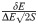
Binding specificity of ssDNA vs. ssRNA.To judge the specificity with which different sequences of ssDNA and ssRNA bind to the cold shock protein (2ES2.pdb and 3PF5.pdb, respectively), the intrinsic specificity ratio, ISR = δEΔE√2S, was calculated. The δE term represents the energy gap between the native binding state (average binding energy of all near-native structures from the simulation obtained by applying the condition DConf1,DConf2≤3Å) and the average non-native binding states (average binding energy of all non-native binding conformations from the simulation), ΔE is the energy variance of the non-native states and S is the entropy of binding energy. The non-native interactions are defined as conformations that have low binding energy (i.e., a negative binding energy) and that satisfy DConf1,DConf2>3Å). The entropy is estimated as Σplog(p), where p is the probability of having non-native conformation with a certain binding energy obtained by binning. Panels show the values of δE, ΔE, S, and specificity for complexes of the cold shock proteins with ssDNA (red) and ssRNA (blue). A higher energy gap, lower energy variance, and slightly lower entropy were found for ssDNAs compared to ssRNAs. Thus, compared with their ssRNA counterparts, ssDNAs are found to have a higher binding specificity.